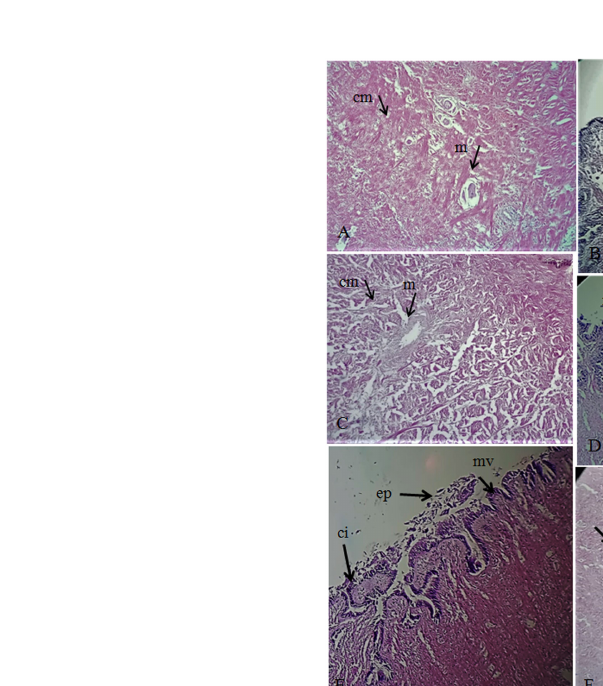
resulted in eroded epithelium and scattered and deranged cilia with deformed microvilli. The eroded epithelium, disruption of columnar muscle fi bers with gap between the cells, and empty and shrunken mucocytes can be seen (Figures 6C, D). The